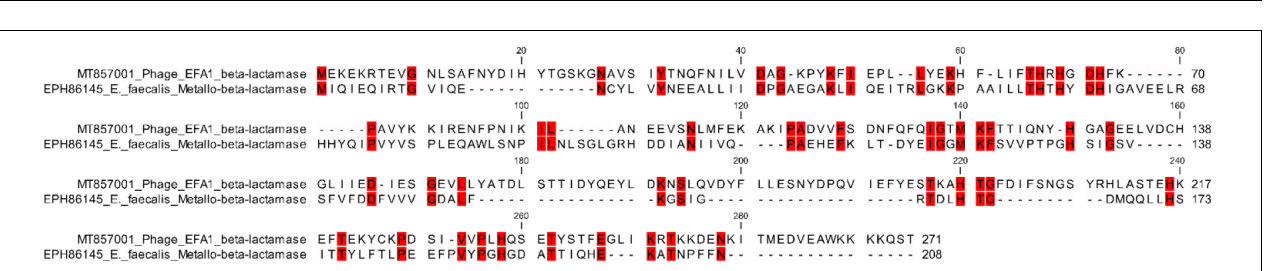
FIGURE 2 | Bacteriophage EFA1 genome orientated according to bacteriophage termini (PAC site). Putative genes coding for DNA packaging (purple), capsid genes (green), tail genes (blue) and putative endolysin (red) are orientated in the left-to-right direction, while putative DNA manipulation genes (pink) are in the opposite direction. Other putative genes whose functionality could not be predicted were considered hypothetical genes (yellow).